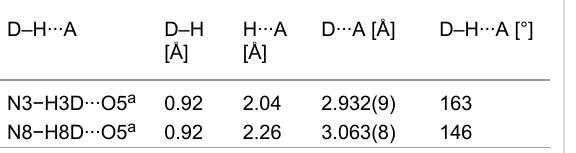
Table 3: Selected hydrogen-bond lengths (Å) and bond angles (°) of complex 1 .